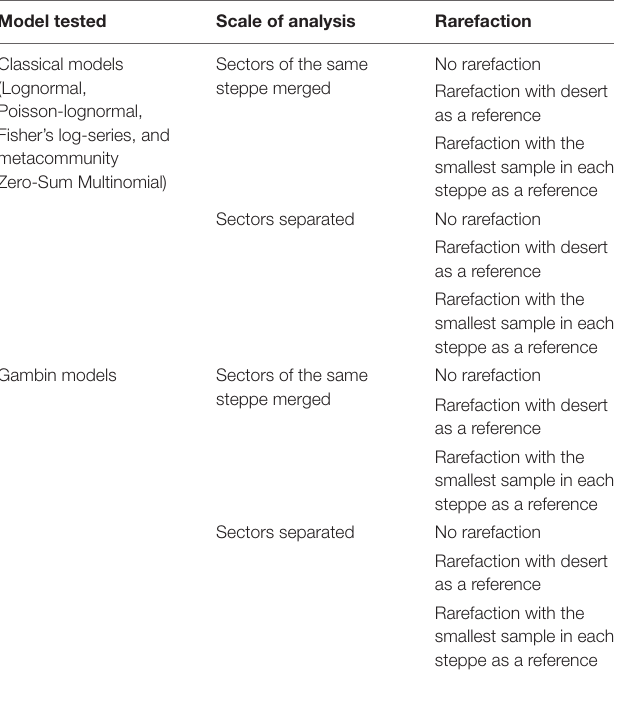
TABLE 1 | Schematic description of the various forms of analyses developed in this article. Model